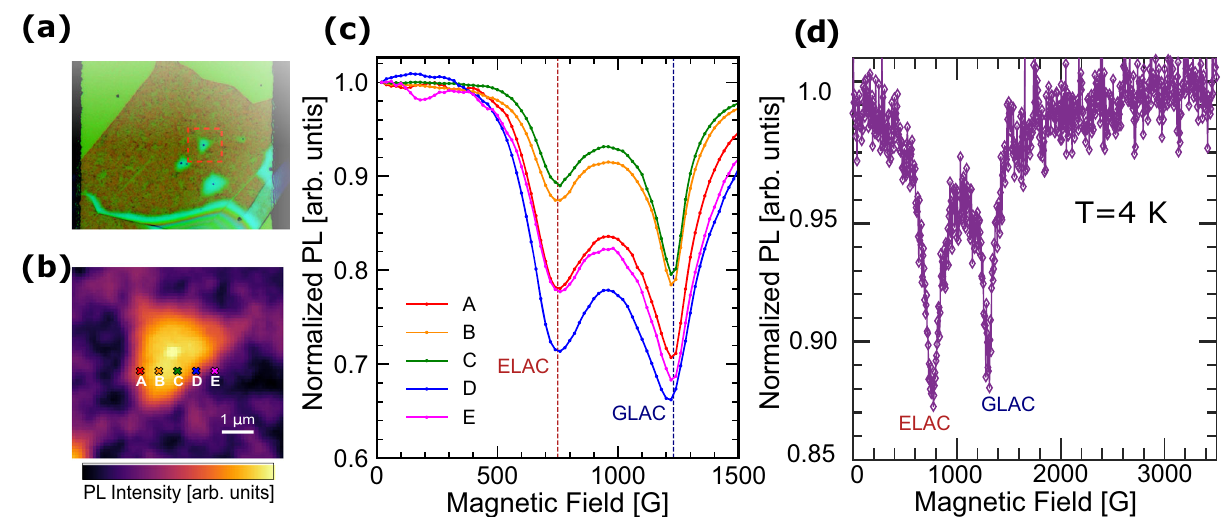
Fig. 5 Magnetic- fi eld-dependent PL and level avoided crossings. a Optical micrograph of an hBN fl ake on the Au CPW. Micro-bubbles are formed during the transfer process, from which we can study the effect of the magnetic- fi eld angle on the level anti-crossings (LACs). b Spatially resolved PL intensity map of the region indicated by the red dashed box in a . c Field-dependent PL measurements collected at the corresponding marked locations in b show reduction in PL at the ELAC and GLAC fi eld values predicted by our CW ESR results. Variation across locations around the micro-bubble indicate that more ! spin mixing occurs at greater angles with respect to B 0 . d Field-dependent PL upto 3500 G. No additional LACs are